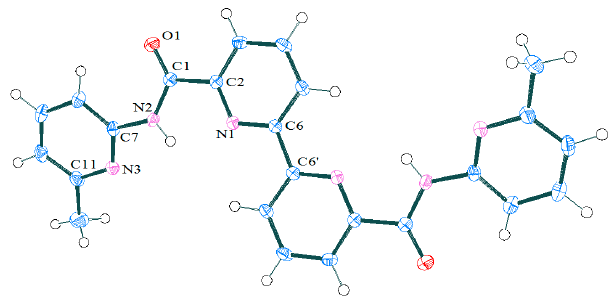
Figure 1. Molecular structure of 2a showing the atom numbering scheme. Displacements ellipsoids are drawn at the 50% probability level and H atoms are shown as small spheres arbitrary radius. Table 2 . Comparison of the several interatomic distances (Å) and angles (°) of the primary diamide 2a with secondary diamide analogs.